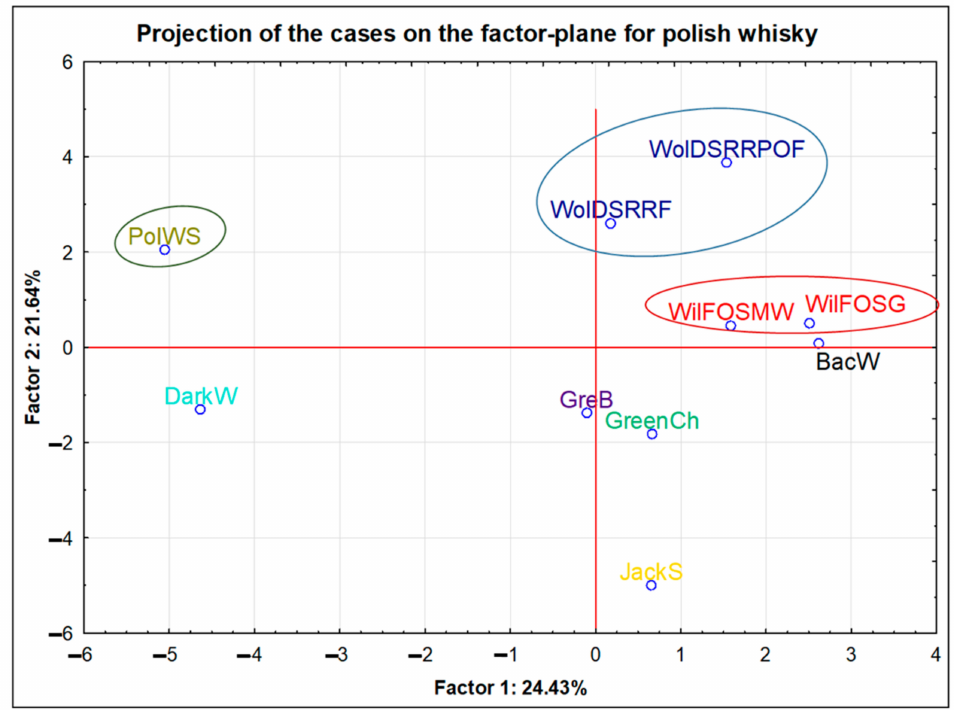
Figure 3. Projection of the cases on the factor-plane for the 10 samples from Poland investigated in this